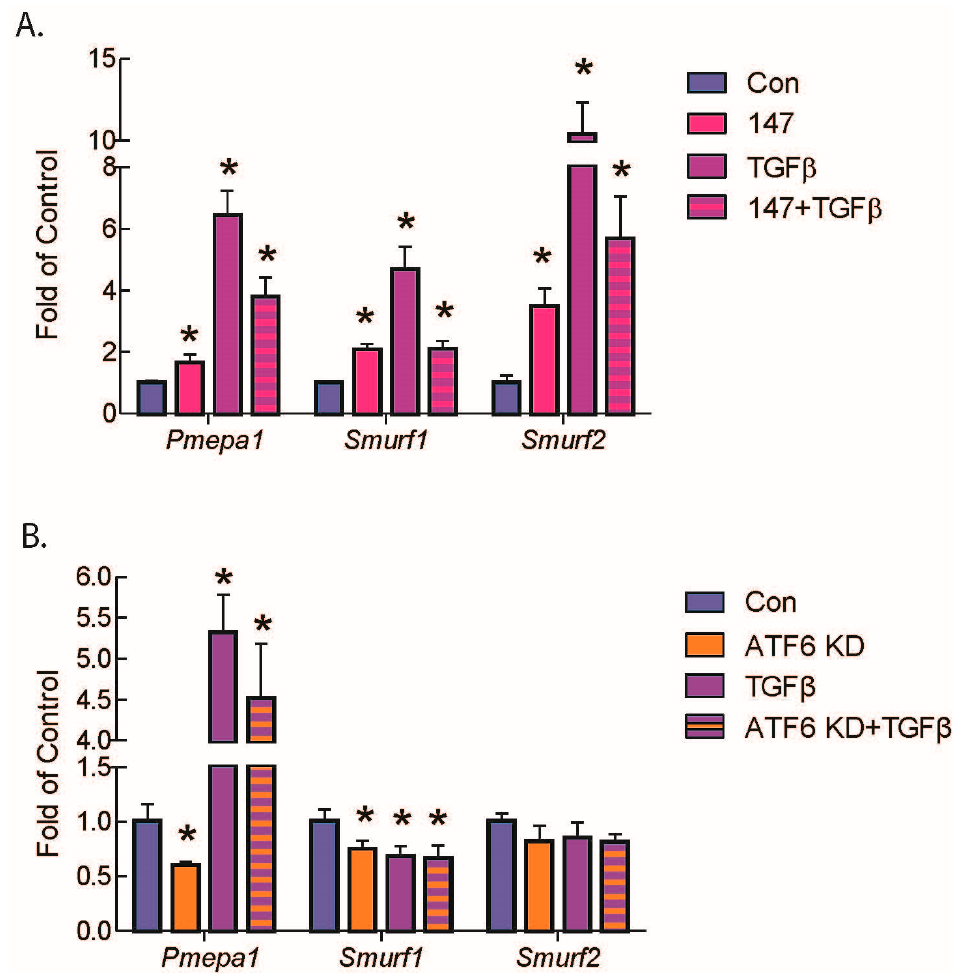
Figure 6. qRT-PCR of AMVFs treated with compound 147 or ATF6 knockdown and/or TGF β . AMVFs were treated with ( A ) ±10 μ M compound 147, ±10 ng/mL TGF β , or ( B ) ±siRNA to ATF6, ±10 ng/mL TGF β , then analyzed by qRT-PCR for Pmepa1, Smurf1, and Smurf2 , as shown. All treatments were for 48 h. * p ≤ 0.05 by one-way ANOVA within each gene group. * Indicates significant difference between a condition and control according to Newman–Keuls post-test.